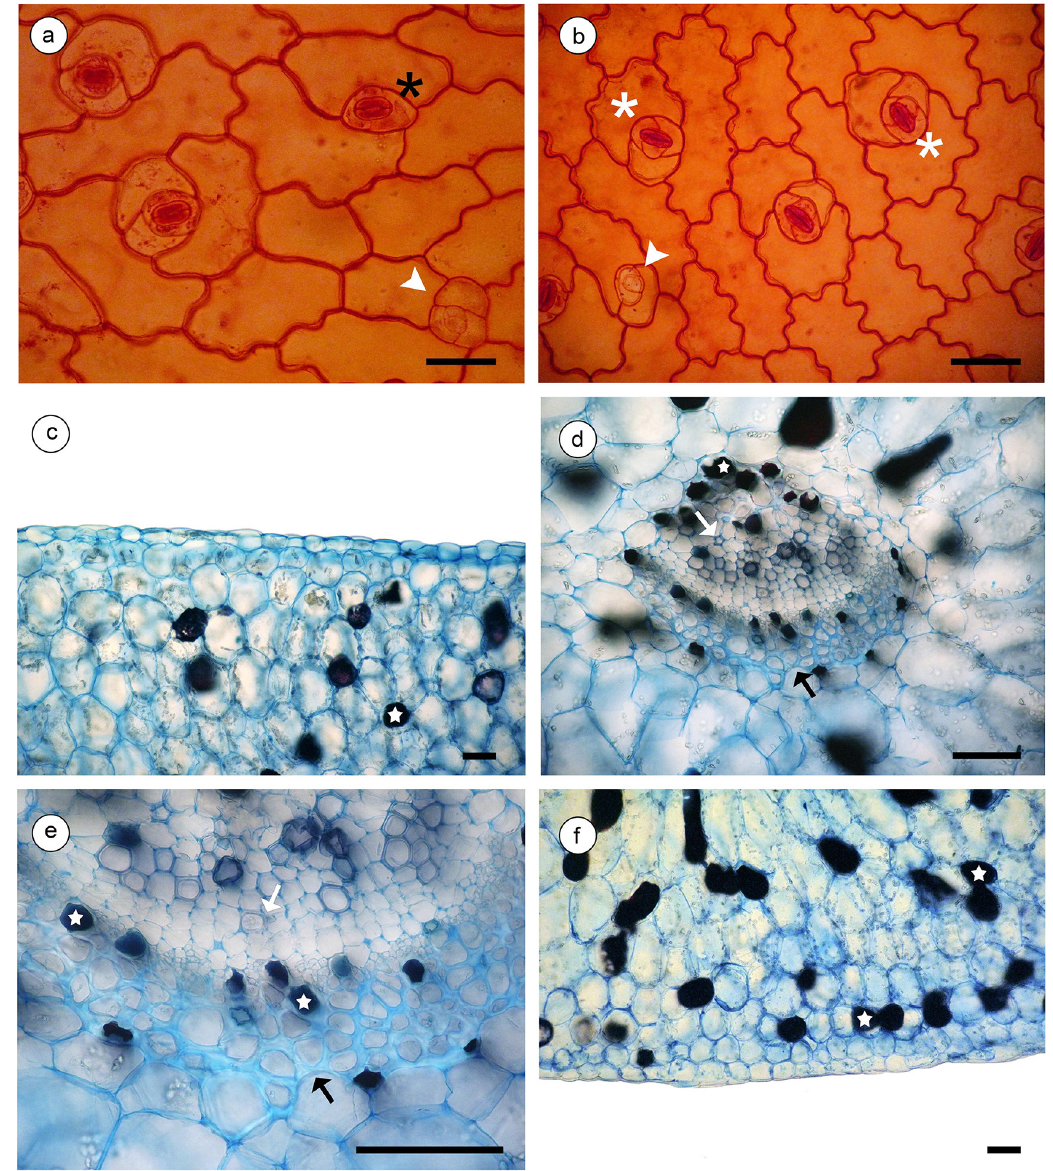
Fig. 2: Sections of the middle third of the Kalanchoe fedtschenkoi leaf blade. a - b – paradermal sections revealing cells with sinuous anticline walls: adaxial surface (a) and abaxial surface (b); black asterisks: anisocytic stomata; white asterisks: helicocytic stomata; arrowheads: developing stomata. c - f – cross sections: adaxial side (c); main vascular bundle with collenchymatic tissue (black arrow) (d); detail of the main vascular bundle (e); abaxial side (f); idioblasts with dark brown content (stars). Bars 100 μm. order to evidence the presence of different classes of polyphenols in plant samples. It is also used to reveal these substances in plant tissue sections ( c aSanova et al., 2020). While flavonoids are revealed as orange, yellow, or green by this reagent; hydroxycinnamic and hy- droxybenzoic acid derivatives are highlighted in blue and greenish- blue color ( W agner and b ladt , 2001). Some compounds exhibit an intrinsic fluorescence (autofluorescence), which does not require the addition of NP in order to be observed. These include chlorophyll, which shows a red color ( l ang et al., 1991) and lignin, which fluo - resces in blue ( d onaldSon and r adotic ,